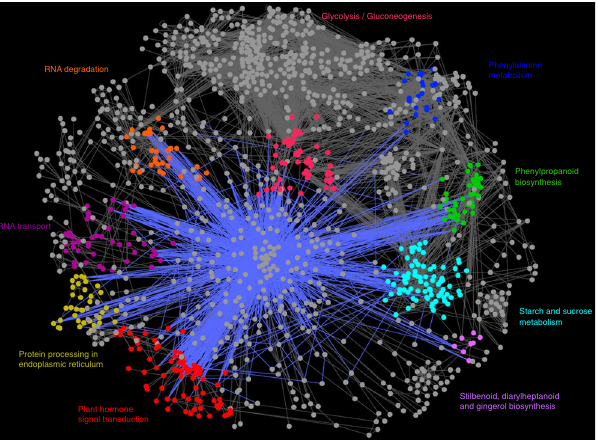
Figure 5. Regulatory network underlying the co-regulated genes in P . euphratica response to salt stress. Nodes involved in nine prominent pathways are marked in different colors. The blue edges indicate TFs binding